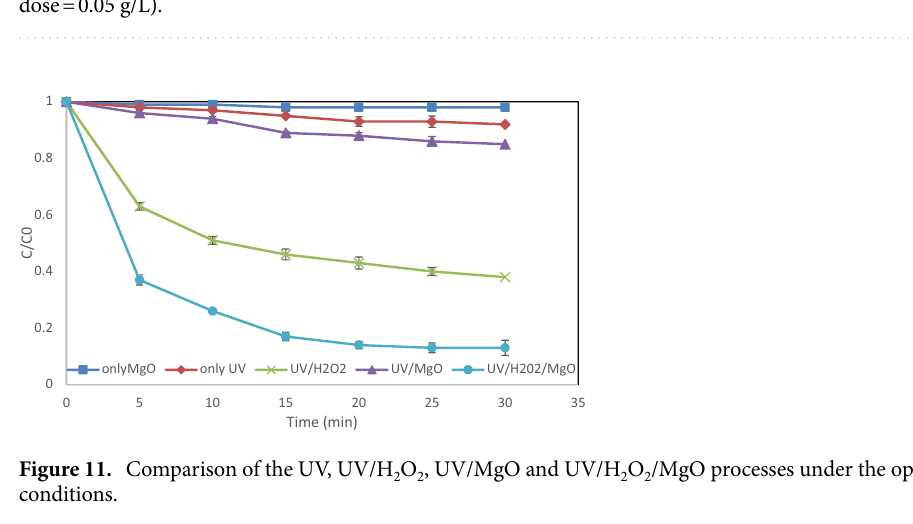
Figure 10. TOC and COD removal (initial DEX concentration = 20 mg/L, pH = 3, H 2 O 2 dose = 5 mM, andMgO dose = 0.05 g/L).